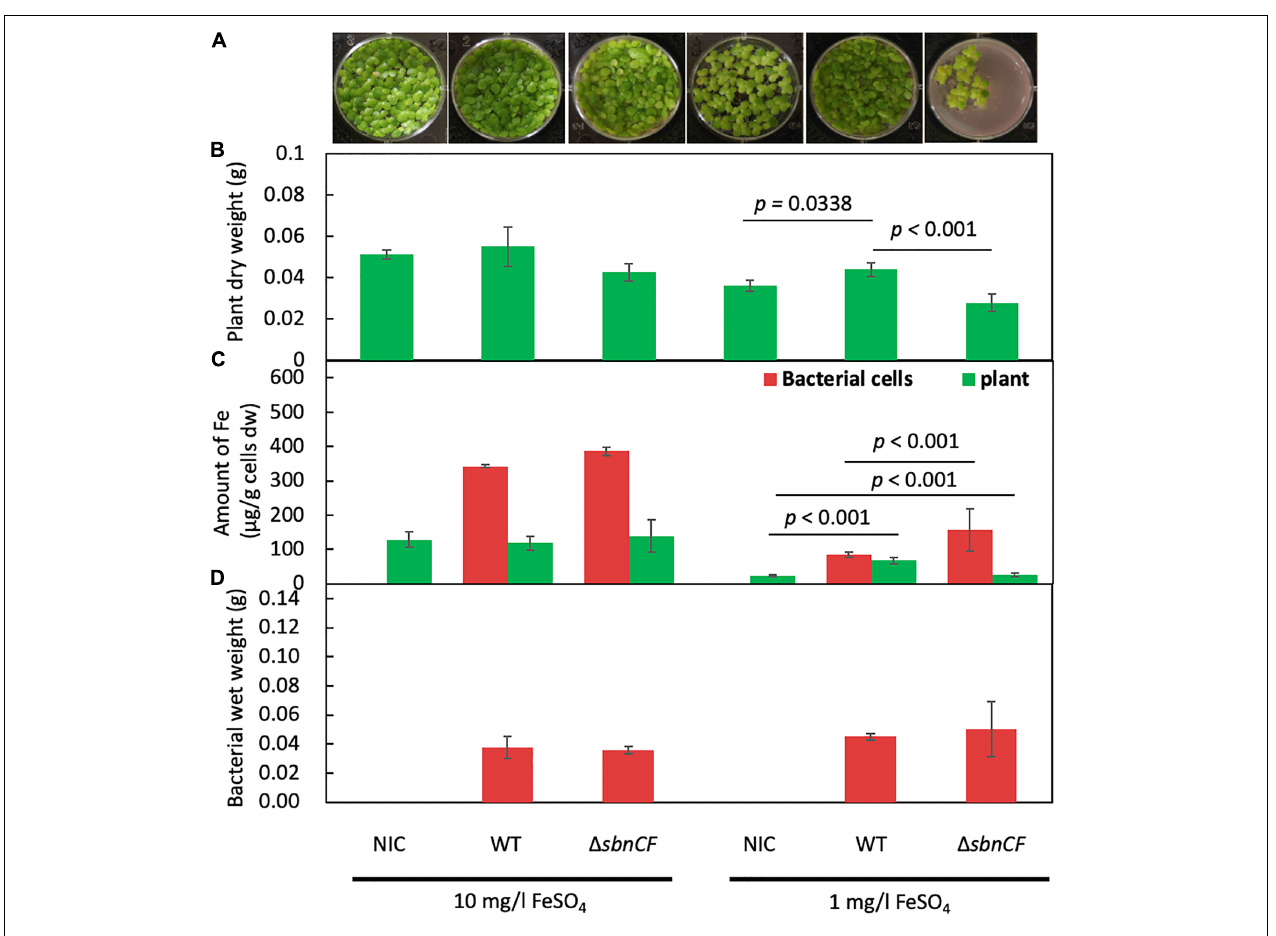
FIGURE 3 | (A) Growth of duckweed plants in liquid 1/2 MS medium inoculated with none (non-inoculated control, NIC), strain 22A wild type (WT), and (cid:49) sbnCF, under 10 and 1 mg/l FeSO 4 for 28 days. Representative pictures are shown for each treatment. (B) Dry weight of plants after cultivation. (C) Iron content in the plants and bacterial cells. (D) Bacterial mass measured as wet weight after cultivation. All the data are reported as the mean of three replicates ± standard deviation